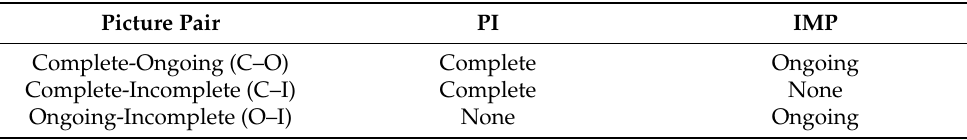
Table 2. Target responses for all conditions and